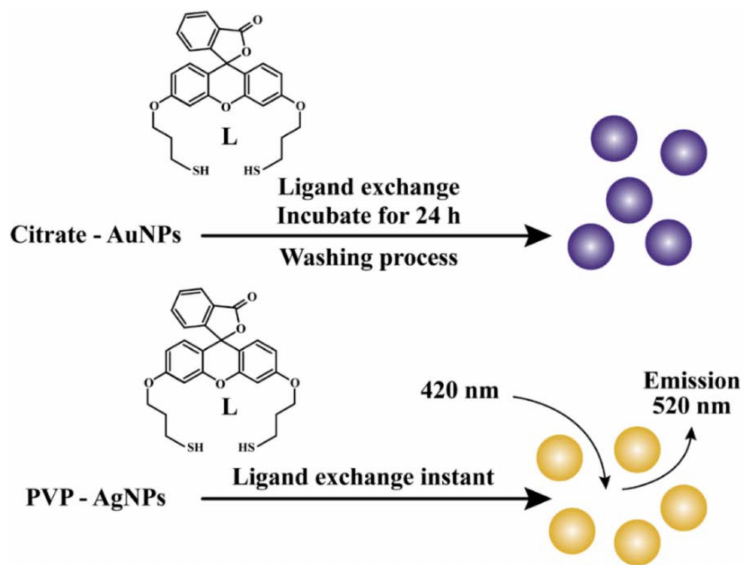
Figure 17. The surface coat of AuNPs and AgNPs using ligand ( L ) and their use in probing of Hg 2+ ions. A label-free colorimetric sensor for Hg 2+ quantitation using gold nanostar